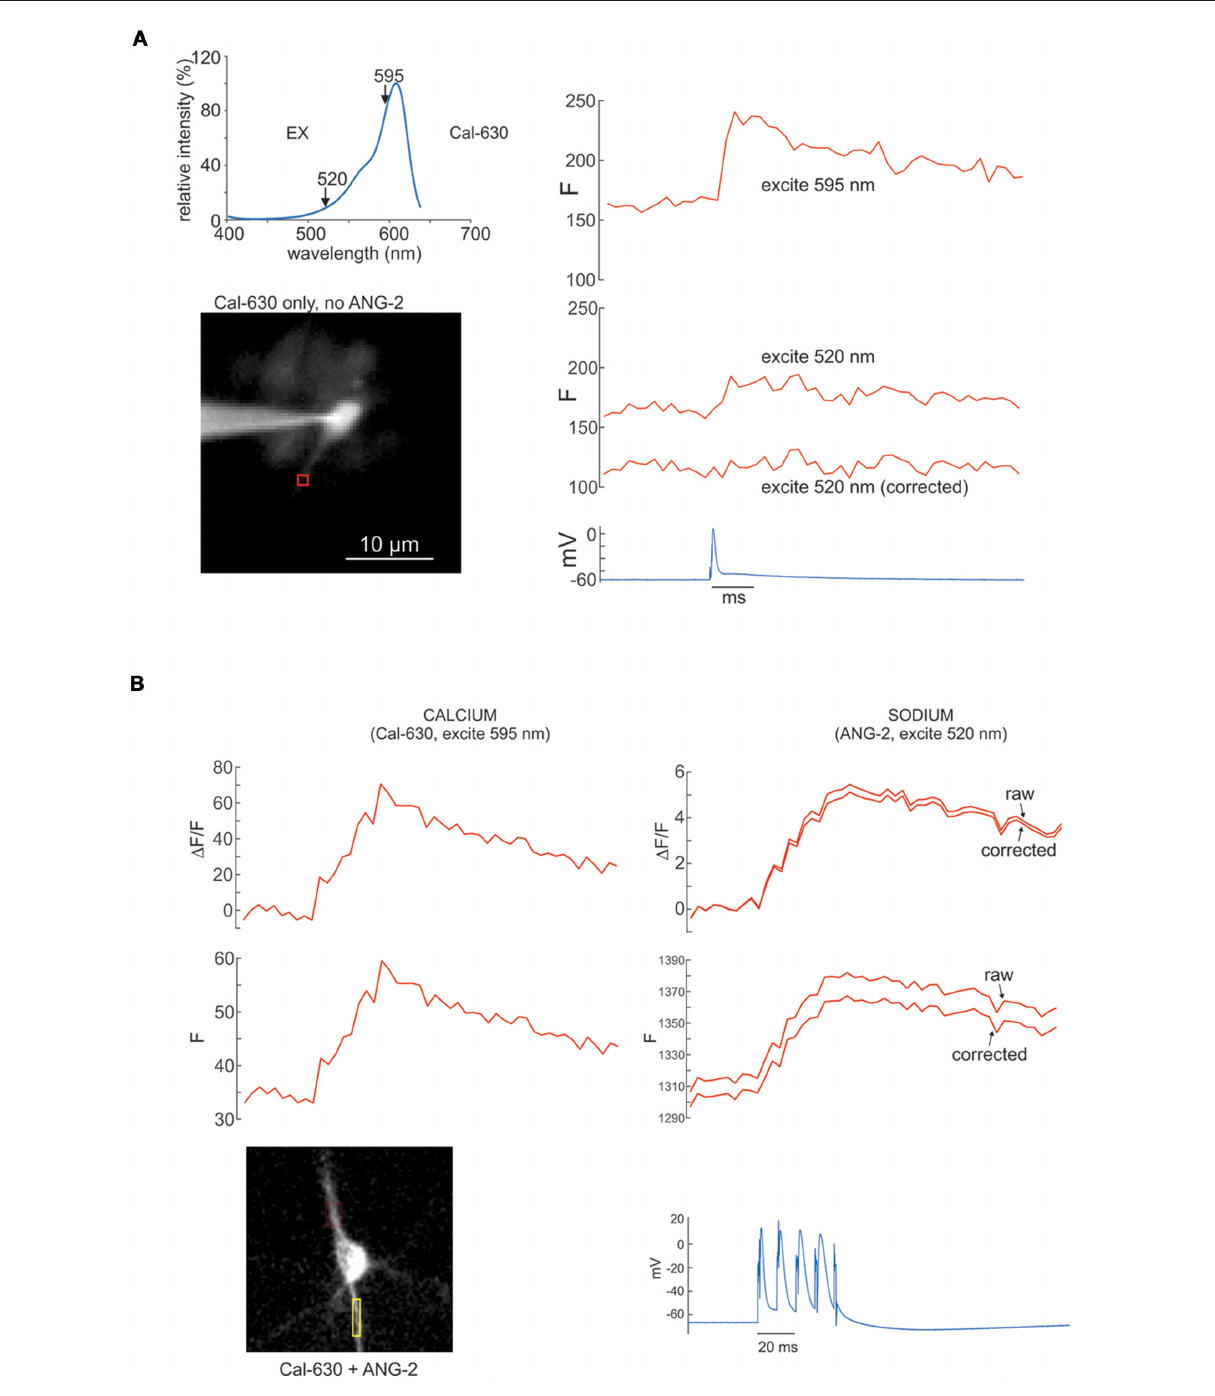
Frontiers in Cellular Neuroscience | www.frontiersin.org